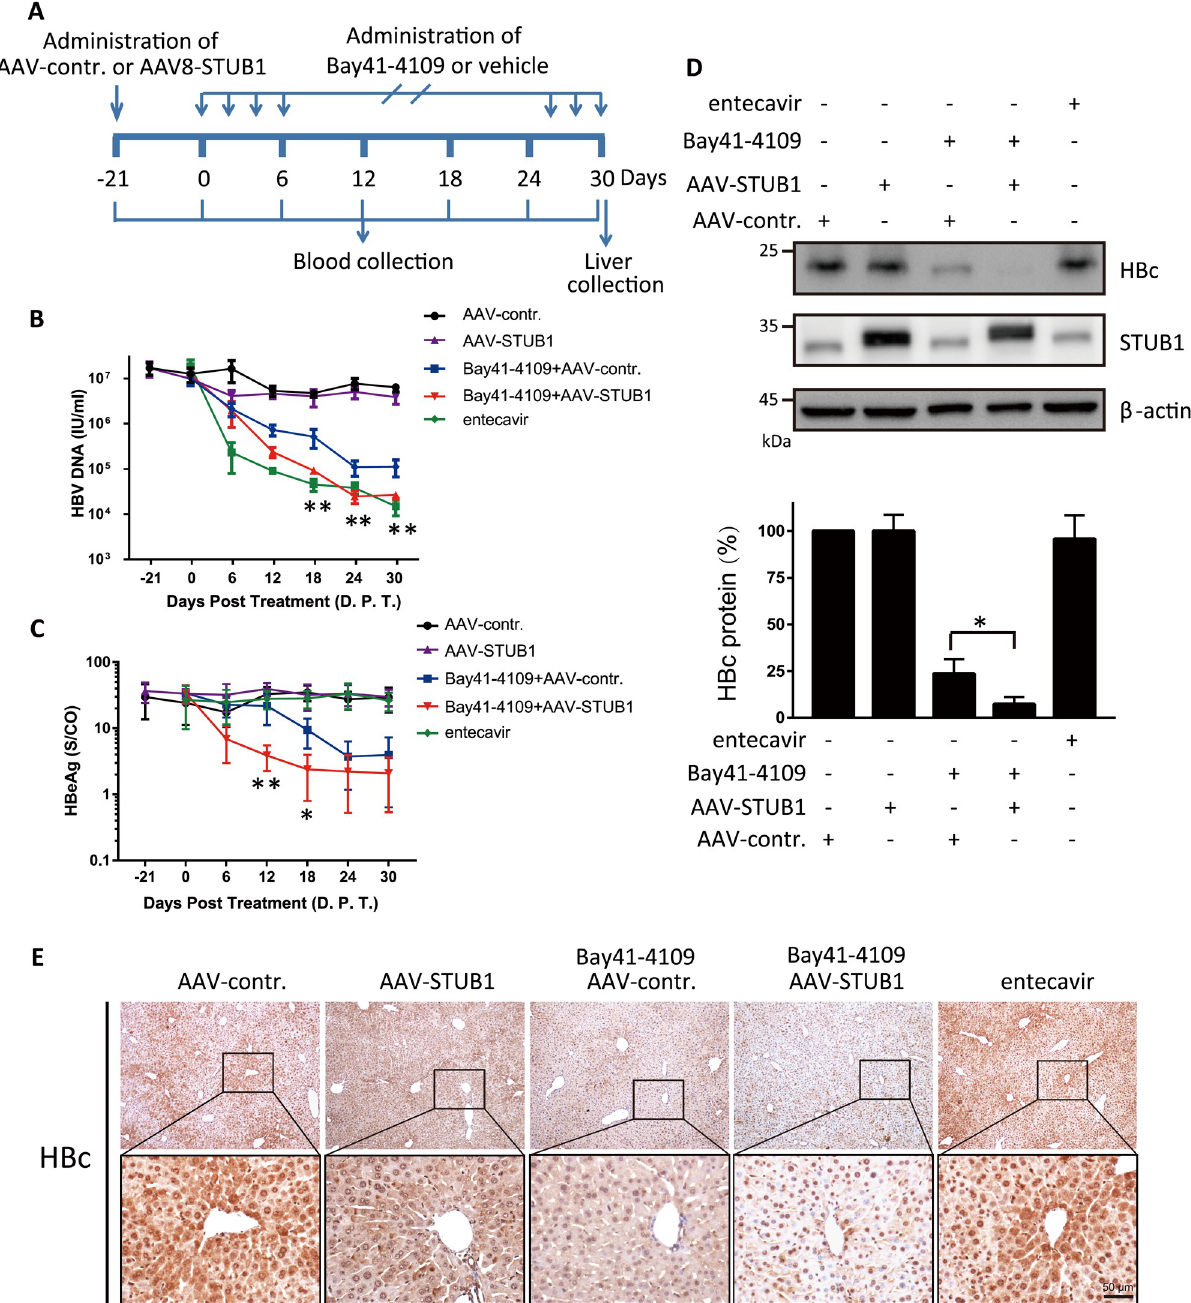
Fig 9. STUB1 enhances Bay41-4109’s inhibitory effect in HBV transgenic mice. (A) Schematic diagram of the procedure for treating HBV transgenic mice. (B, C) Levels of HBV DNA (B) and HBeAg (C) in serum were quantified every 6 d. S/CO is the signal-to-cutoff ratio. The error bars indicate ± SD. Bay41-4109-treated AAV-STUB1 group and Bay41-4109-treated AAV-control group were analyzed by unpaired two-tailed student’s t- test. � p < 0.05. �� p < 0.01. (D) The indicated proteins in the livers of each group were detected with immunoblotting (upper panel). The levels of HBc were quantified in three mice of each group (lower panel). (E) The levels of intracellular HBc in the livers were detected by IHC analysis. Scale bar, 50 μ m.